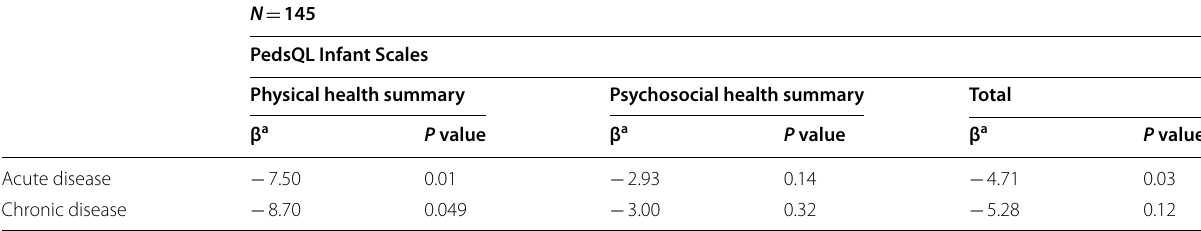
Table 6 Known-groups validity of the Japanese version of the PedsQL Infant Scales